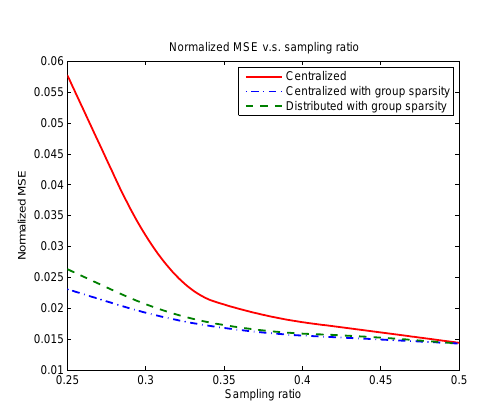
Figure 7. Normalized MSE of spectrum estimation